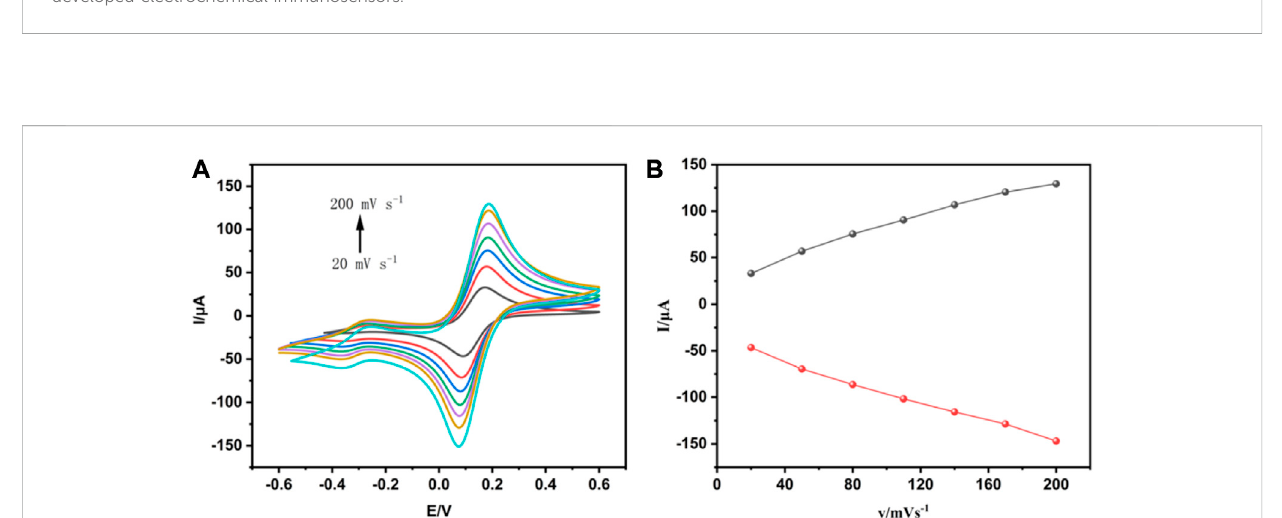
Analysis of the interfacial characteristics of modi fi ed electrode surfaces using CV techniques. (A) The cyclic voltammogram of the electrochemical immunosensor obtained at different scan rates. (B) The relationship between the redox peak current and the scan